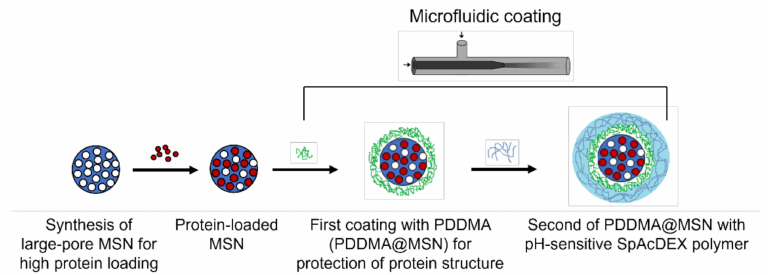
Figure 1. Process scheme applied for microfluidic dual coating of protein-loaded